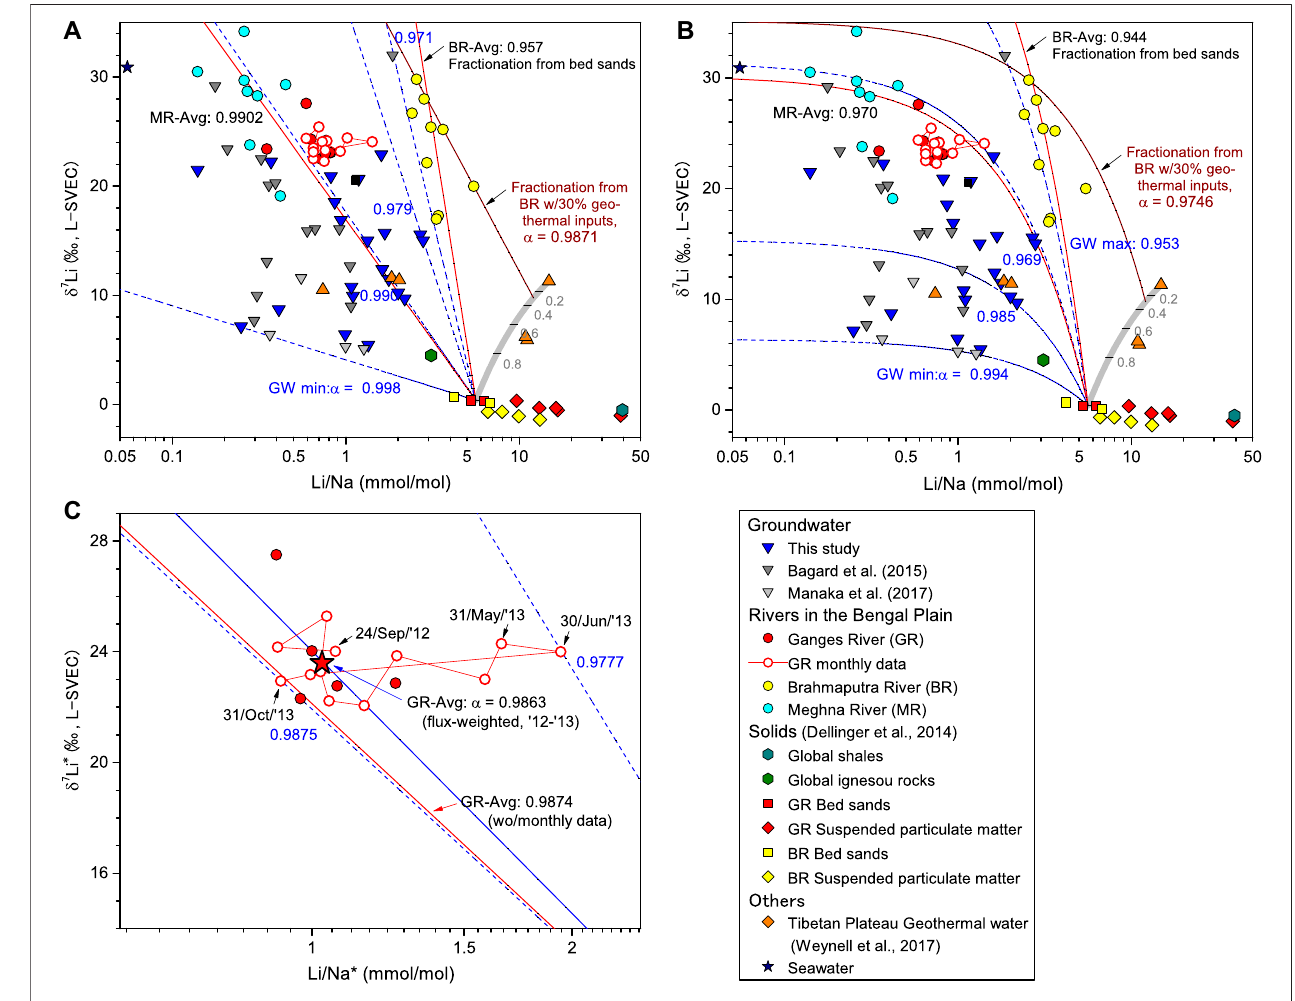
FIGURE3| RelationshipsbetweentheLi/Naratio( μ molkg − 1 /mmol kg − 1 ) andthe δ 7 LiintheGanges-Brahmaputra-Meghnariversand groundwaterinBangladesh from thisstudyand previous studies (A) Rayleigh-typeand (B) batch-type fractionation from thestartingcompositionofthe averagebed-sands valueintheGangesand Brahmaputrarivers(Li/Na (cid:2) 5.6, δ 7 Li (cid:2) 0.39 ‰ ,(Dellingeretal.,2014).Bluedashedlinesaremaximum,intermediate,andminimumfractionationcurvesforgroundwaters in Bangladesh. Black solid lines are fractionation curves through the average compositions of the Brahmaputra and Meghna rivers, respectively. Gray lines represent binary mixing between silicate and geothermal sources as the starting composition of the Brahmaputra River (C) The Li concentrations and δ 7 Li values of the monthlychangesinGangesRiverwatercorrectedfortheatmosphericcontribution.DashedlinesarethemaximumandminimumRayleighfractionationlinesformonthly change. A red line connects monthly data, and a red star is the discharge-weighted mean δ 7 Li and Li/Na compositions.